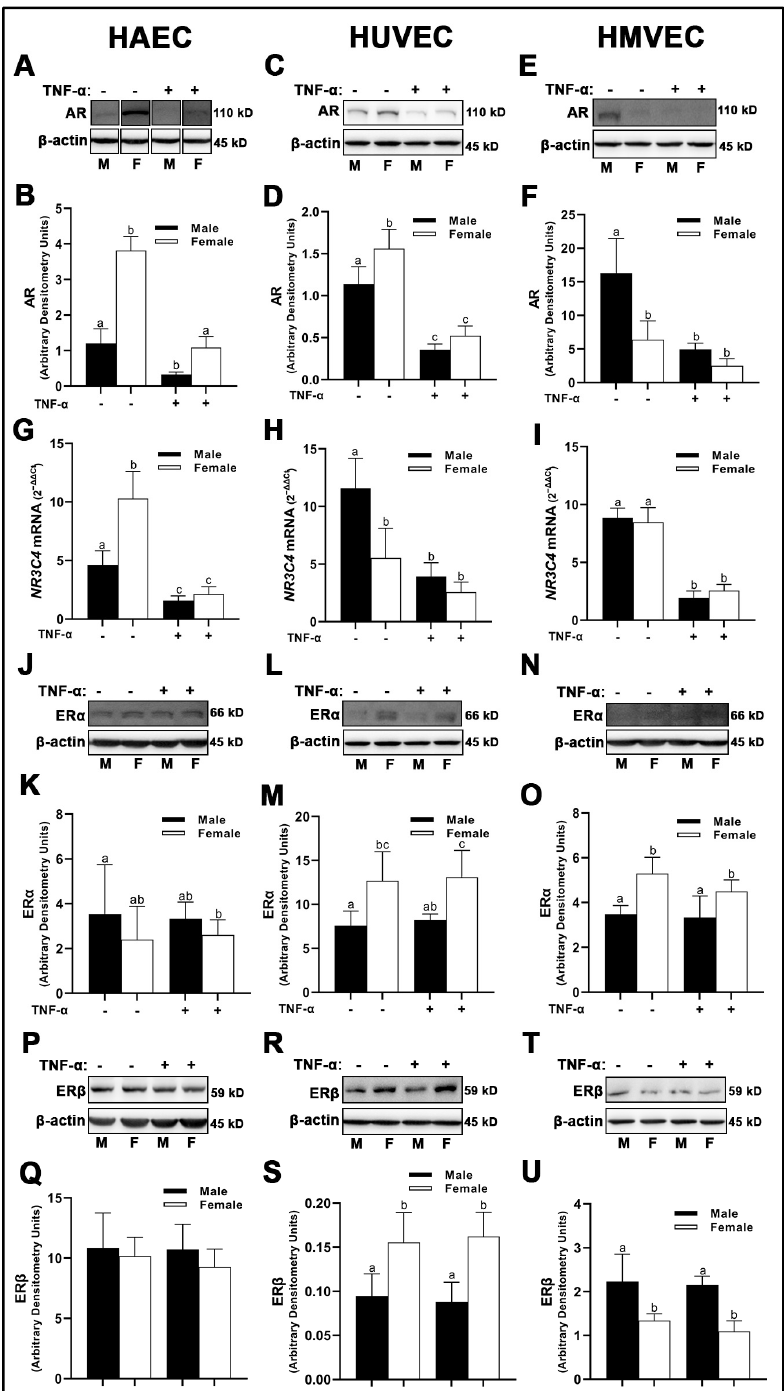
Figure 1. Expression of sex receptors in male and female endothelial cells. HAECs, HUVECs and HMVECs were cultured in starvation medium at ~80% confluency for 24 h with or without TNF- α (20 ng/mL). Protein expression of AR ( A – F ), ER α ( J – O ), and ER β ( P – U ) were determined by Western blot. Quantification was performed using Image Lab (Bio-Rad Laboratories, Inc.). Protein was normalized to respective control bands ( β -actin). Gene expression of AR ( G – I ) were determined with qPCR. Genes of interest were normalized to housekeeping gene cyclophilin. Data are expressed as mean ± SD from 3–6 experiments. Data were statistically analyzed with one-way ANOVA followed by Tukey post hoc multiple comparison analysis between groups. Values that do not share the same letter are significantly different from each other ( p ≤